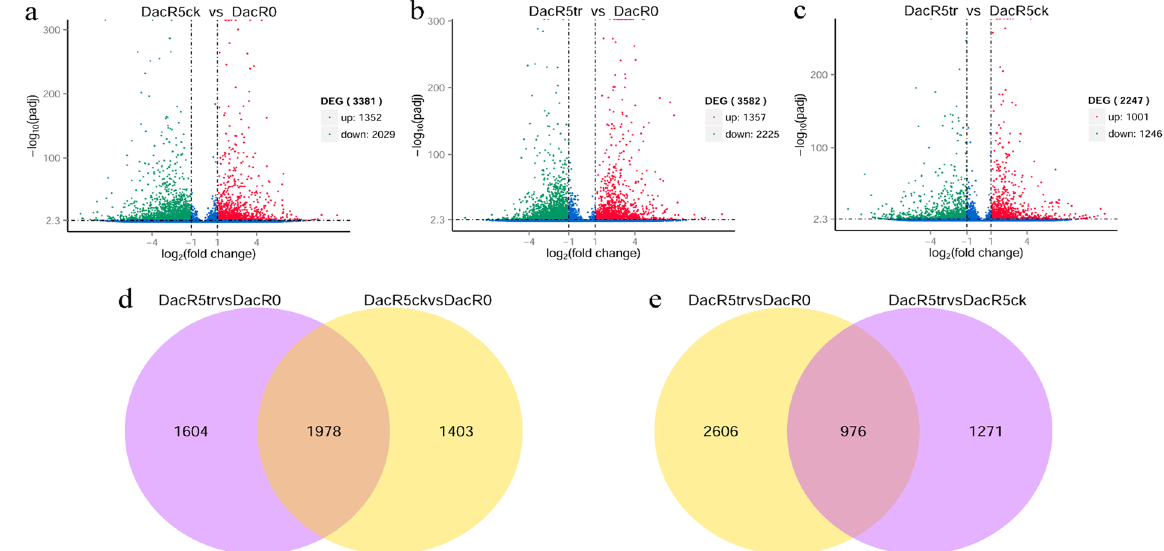
Figure 1. Filtering differentially expressed genes between samples. Volcano plot was used to show the overall distribution of differentially expressed genes (DEGs). In part a, b and c of this figure, gene with |log2 (foldchange)| > 1 and q-value < 0.005 was screened out as significantly DEG. The up-regulated DEGs were represented by red dots, while down-regulated DEGs were represented by green dots. The x-axis means the fold change of DEGs, and the y-axis is the p-value after normalized. The bigger the − log10(padj), the more significant the difference is. Part d and e is the Venn diagram of DEGs between transcriptomes